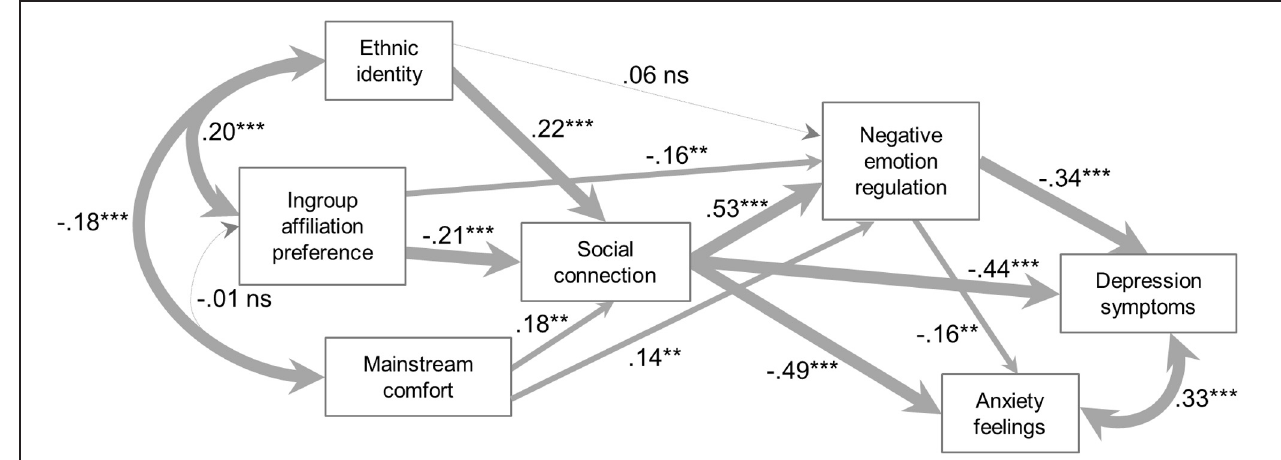
FIGURE 1 | All participants ( N = 312).